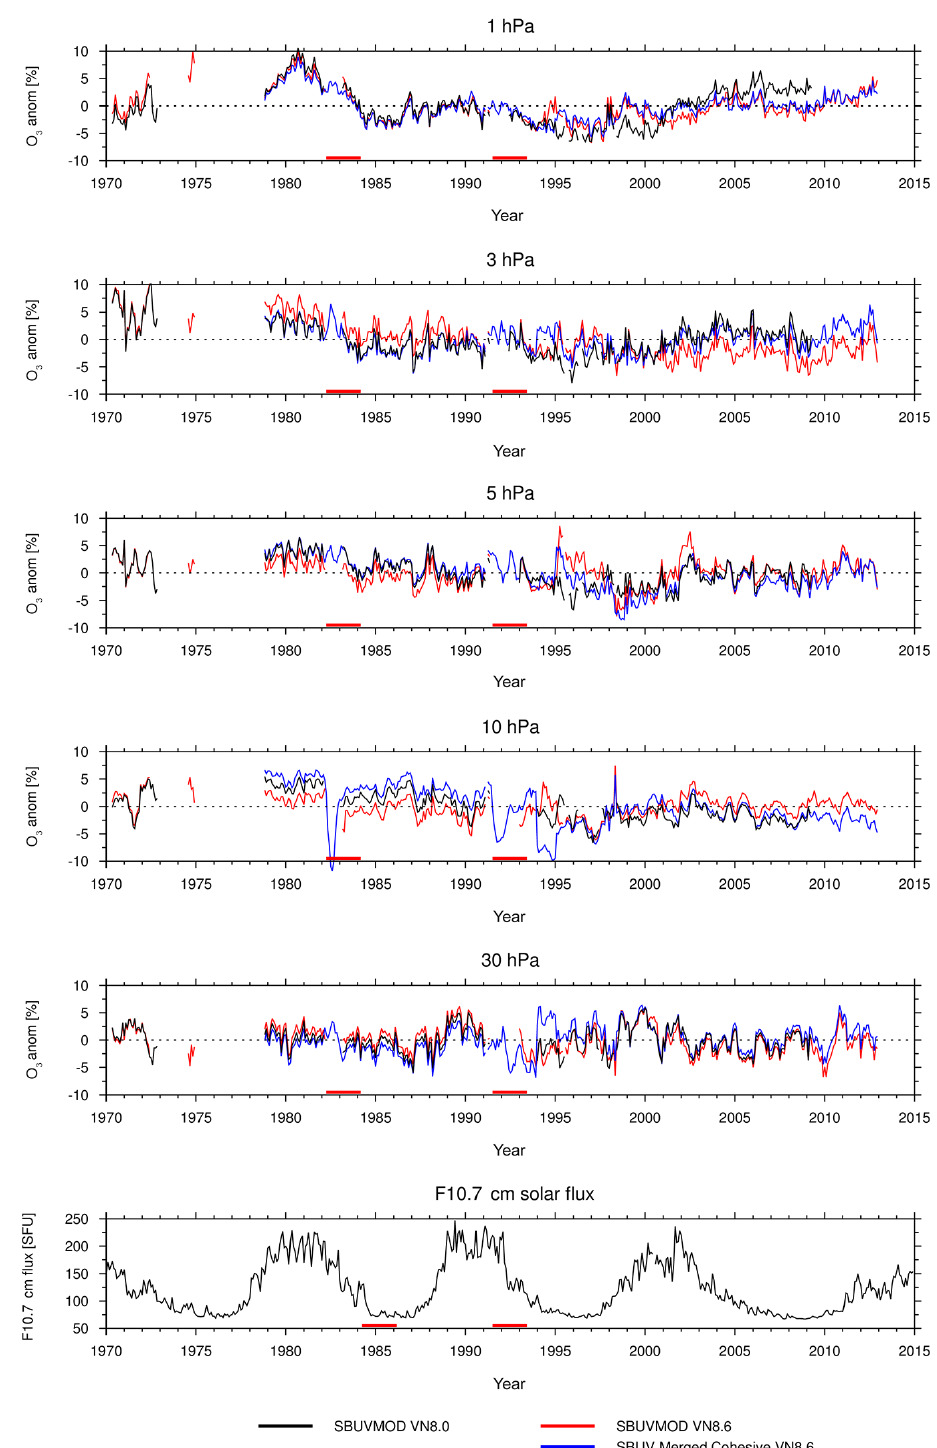
Figure 11. As in Fig. 3 but for the SBUVMOD VN8.0 (black), SBUVMOD VN8.6 (red), and SBUV Merged Cohesive VN8.6 (blue) datasets. The time period is